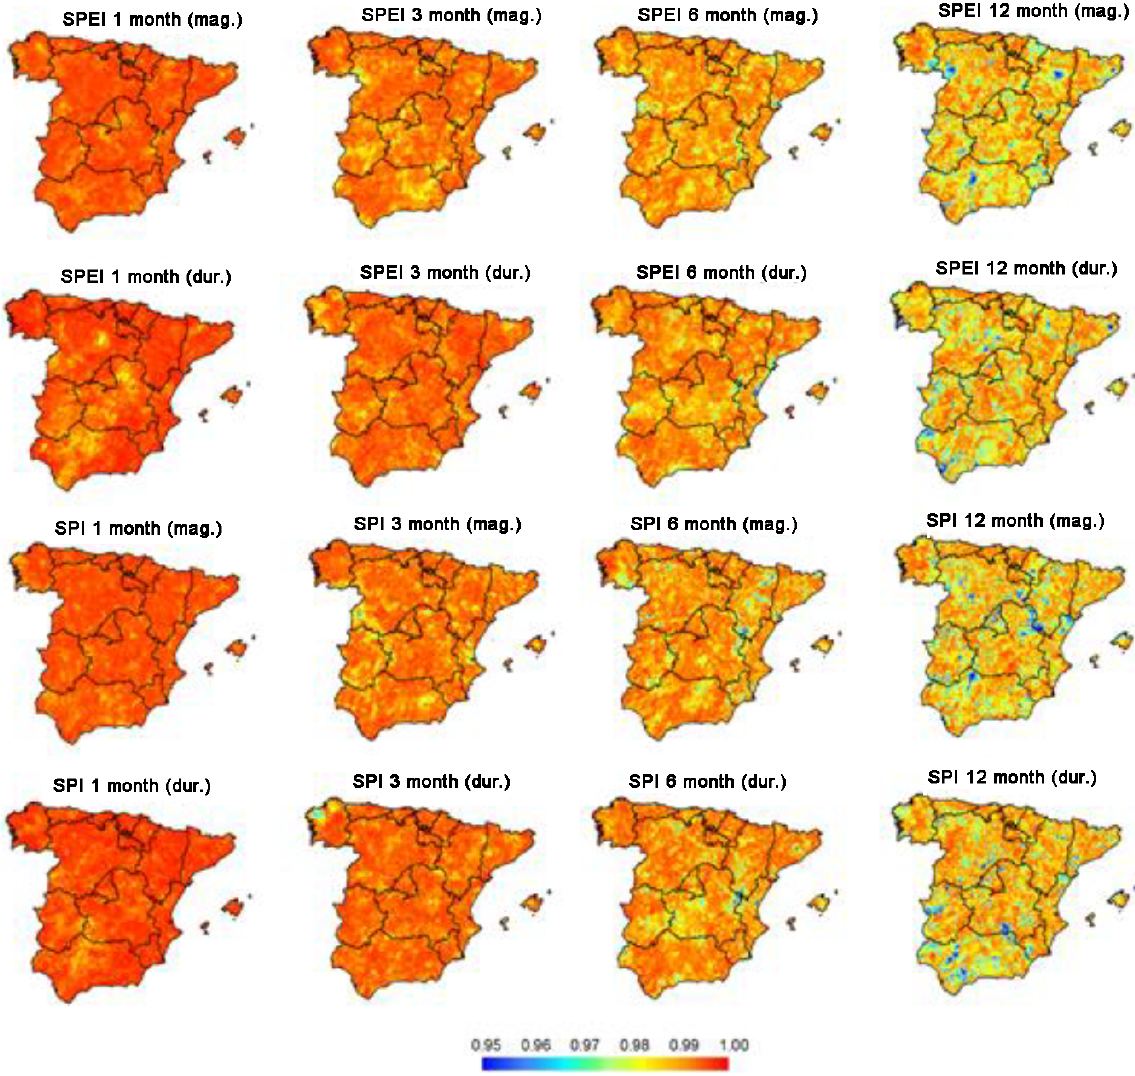
Figure 6. Spatial distribution of the weight correlation coefficients from probability–probability (P–P) plots for the series of 1-, 3-, 6-, and 12-month SPEI and SPI drought duration and magnitude series obtained considering the 80th percentile as a threshold for the peak-over- threshold